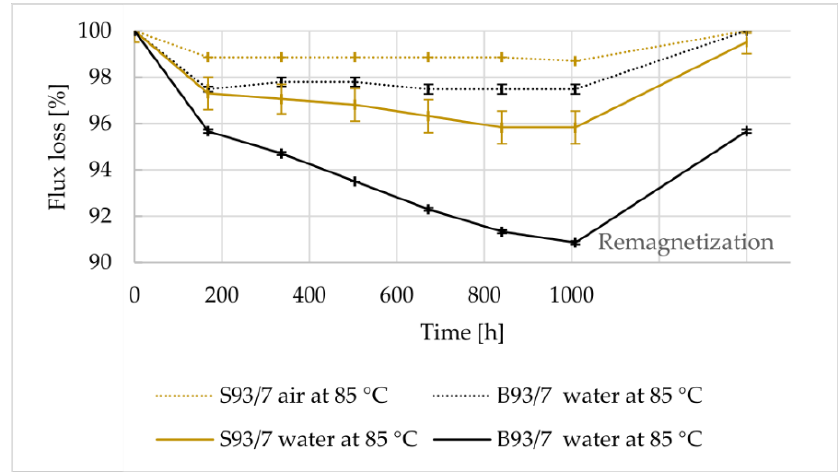
Figure 10. Flux loss of FDM-printed samples S93/7 and B93/7 vs. time exposure to hot water and air at 85°C, and after final remagnetization.